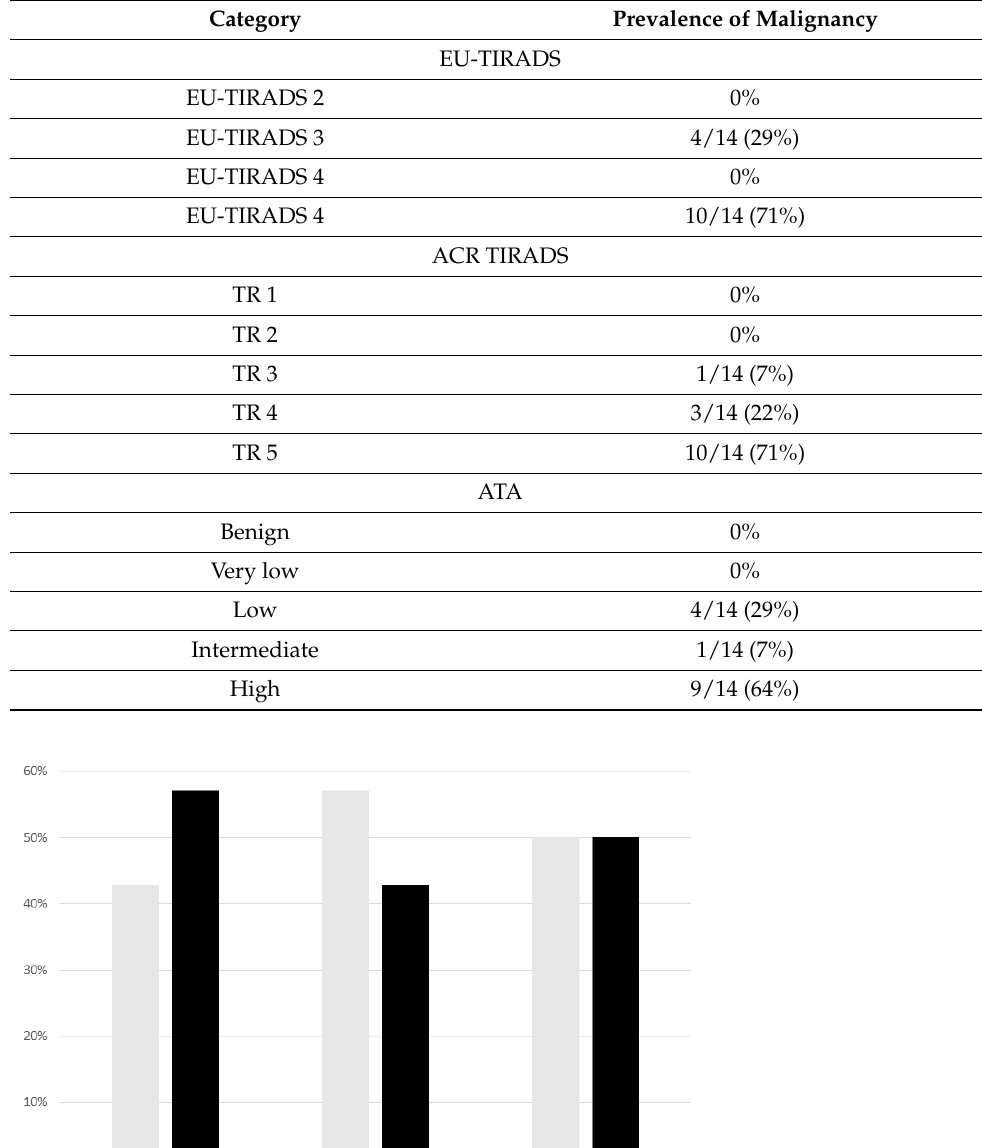
Table 3. Frequency of malignancy according to the various US-RSSs.